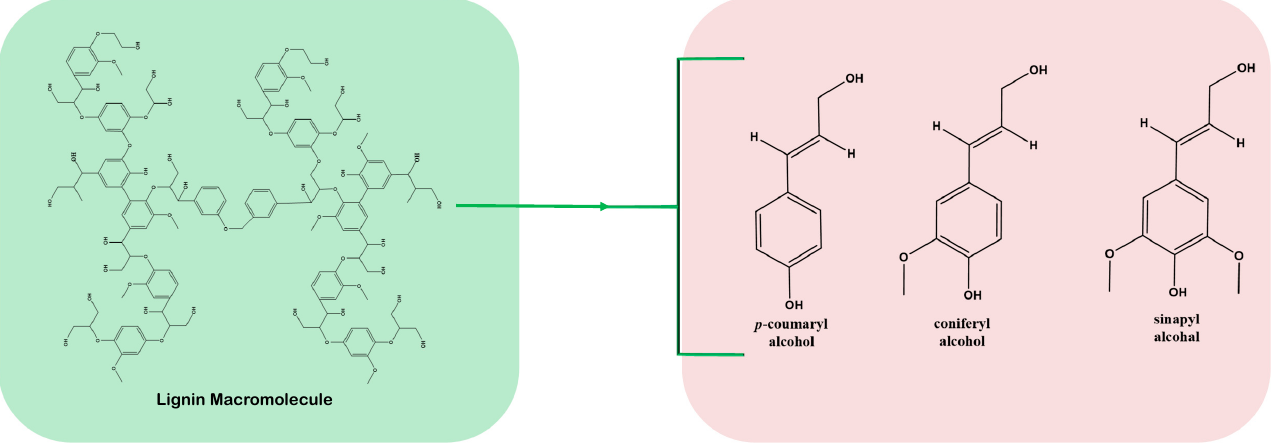
Figure 3. Structure and components of